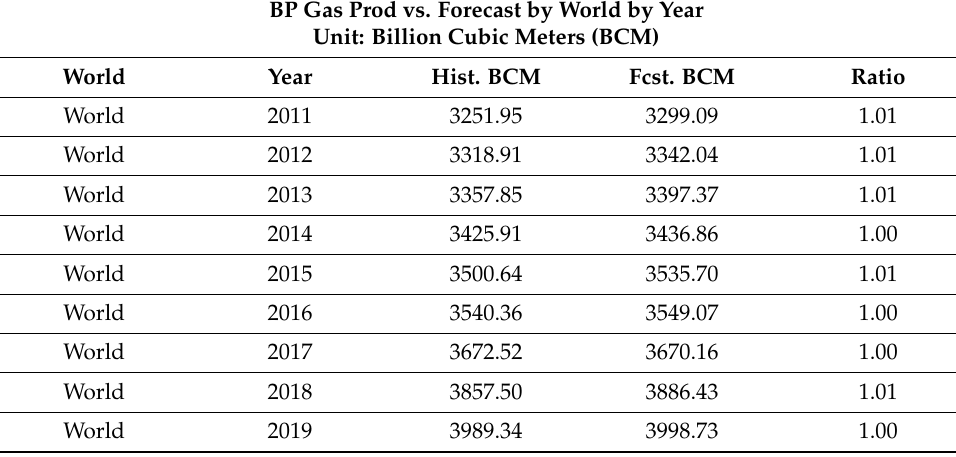
Table A3. G2M2 ® Forecasted Gas Production verus Report Historical by Year. BP Gas Prod vs. Forecast by World by